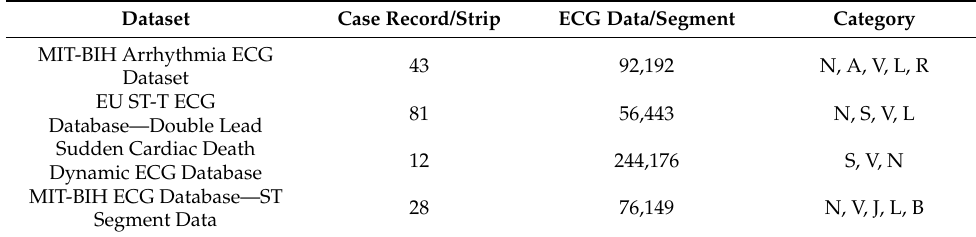
Table 1. Detailed table of case data division.